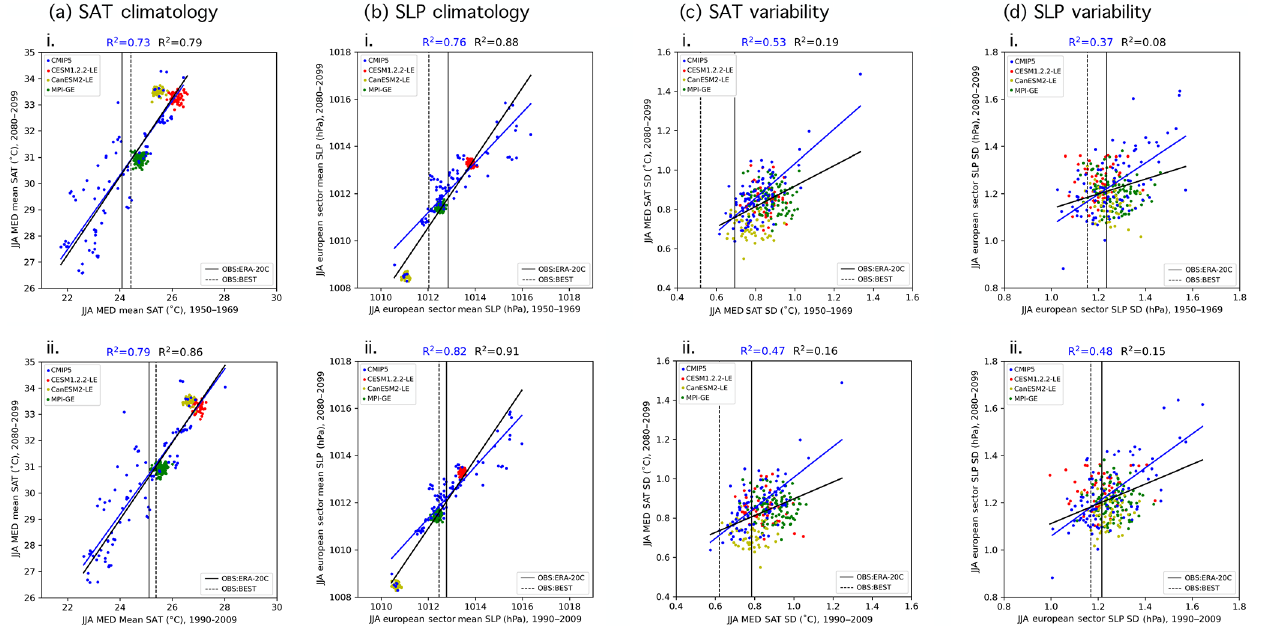
Figure C2. As in Fig. C1, but for JJA and the MED region in (a) and (c)